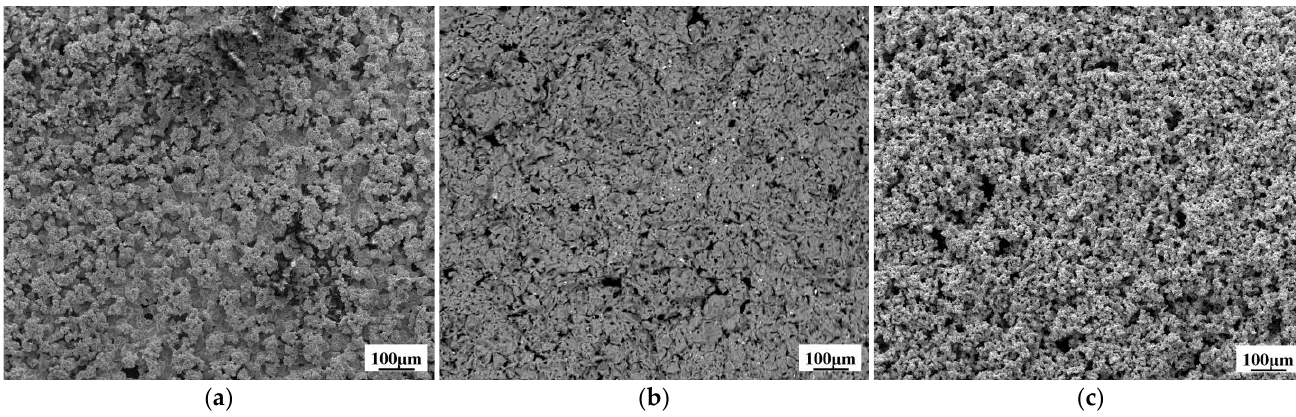
Figure 4. Surface SEM images of the W – Cu composite coatings under different forward duty cycles: ( a ) d f = 20%, ( b ) d f = 40%, and ( c ) d f = 60%, ( J = 2 A/dm 2 , f = 1500 Hz and d r = 5%).